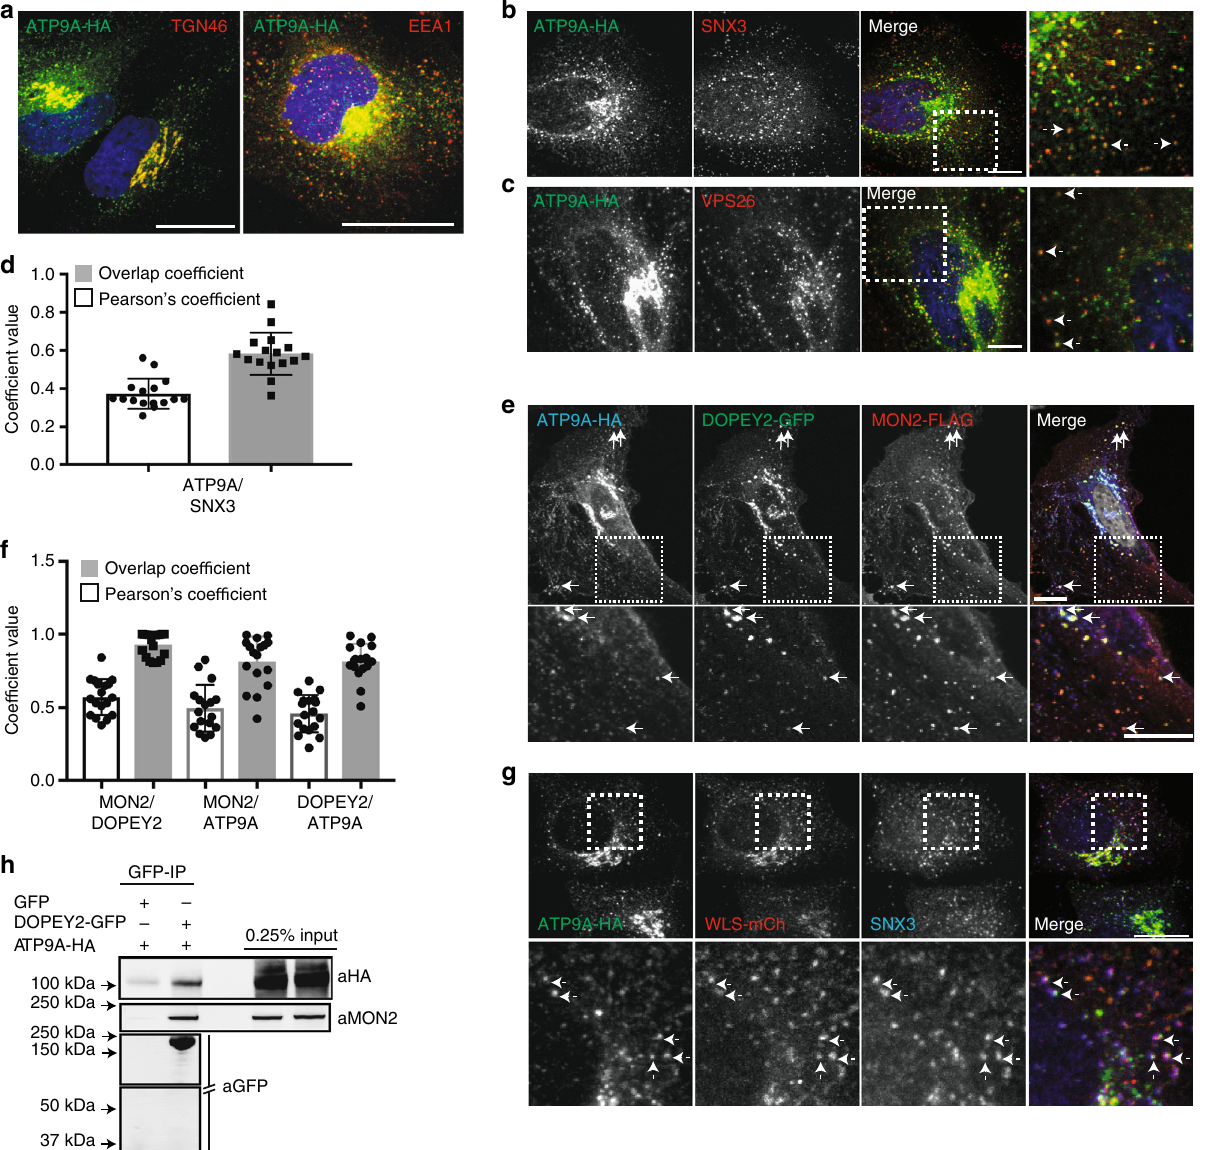
Fig. 4 ATP9A co-localises with MON2 and DOPEY2 on SNX3-retromer endosomes. a ATP9A-HA is found on early endosomes and at the TGN. HeLa cells were transiently transfected with ATP9A-HA and fi xed and stained with an anti-HA (green) antibody and antibodies detecting either endogenous TGN46 or EEA1 (red). The blue staining indicates DAPI. Scale bar represents 10 μ m. b , c ATP9A-HA colocalises on endosomes labelled for the SNX3-retromer components SNX3 and VPS26. HeLa cells were transiently transfected with ATP9A and subsequently fi xed and stained for VPS26 and SNX3. Arrows indicate endosomes co-labelled. The blue staining indicates DAPI. Scale bar represents 10 μ m. d Quanti fi cation of the co-localisation between ATP9A and SNX3 (Pearsons 0.37 ± 0.08, Overlap Coef fi cient 0.58 ± 0.11, n = 15 technical replicates). Error bars indicate s.e.m. e HeLa cells were transiently transfected with ATP9A-HA, DOPEY2-GFP and MON2-FLAG and subsequently fi xed and stained with anti-HA and anti-FLAG antibodies. Arrows indicate endosomes labelled for all three components. Scale bar represents 10 μ m. f Quanti fi cation of the co-localisation between MON2 and DOPEY2 (Pearsons 0.57 ± 0.12, Overlap Coef fi cient 0.92 ± 0.08, n = 18 technical replicates), MON2 and ATP9A (Pearsons 0.49 ± 0.15, Overlap Coef fi cient 0.81 ± 0.17, n = 17 technical replicates) and DOPEY2 and ATP9A (Pearsons 0.45 ± 0.12, Overlap Coef fi cient 0.81 ± 0.11, n = 18). Error bars indicate s.e.m. g HeLa cells were transiently transfected with ATP9A and WLS-mCherry and subsequently fi xed and stained for endogenous SNX3 and HA. Arrows indicate endosomes labelled for all three components. Scale bar represents 10 μ m. h Representative blot showing DOPEY2-GFP binds both MON2 and ATP9A-HA. Cell extracts derived from HEK293 cells transiently transfected with GFP and ATP9A-HA or DOPEY2-GFP and ATP9A-HA were subjected to a GFP nanotrap and subsequently blotted with antibodies raised against HA and